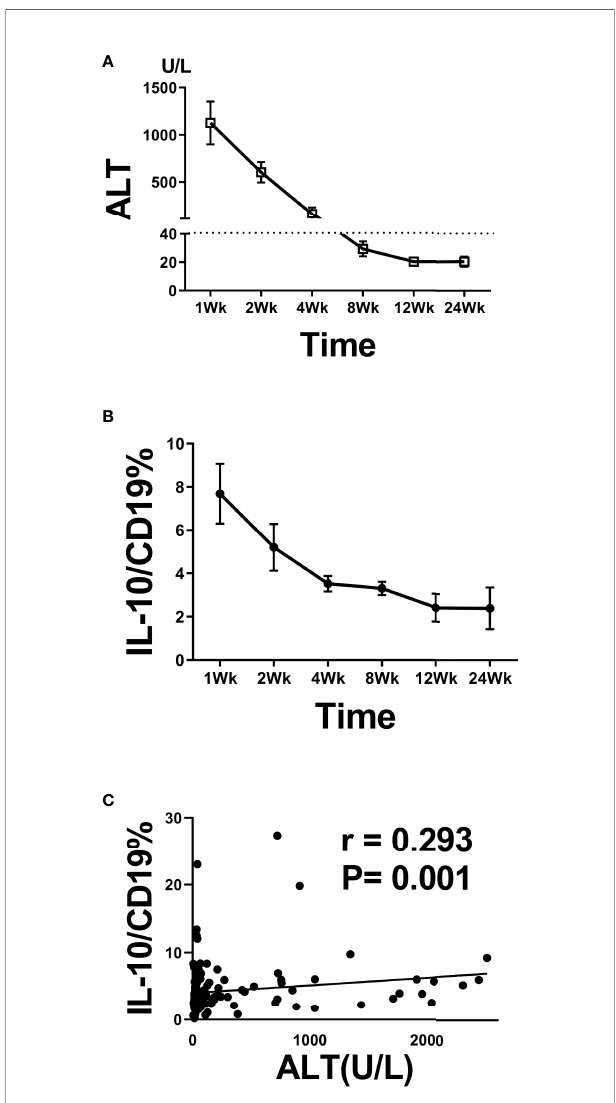
FIGURE 4 | B10 temporal positively associated with ALT during acute HBV infection. Dynamic of ALT (A) and B10 (B) during hospitalization stay time. The positive correlation between B10 and ALT during hospitalization stay time (C)